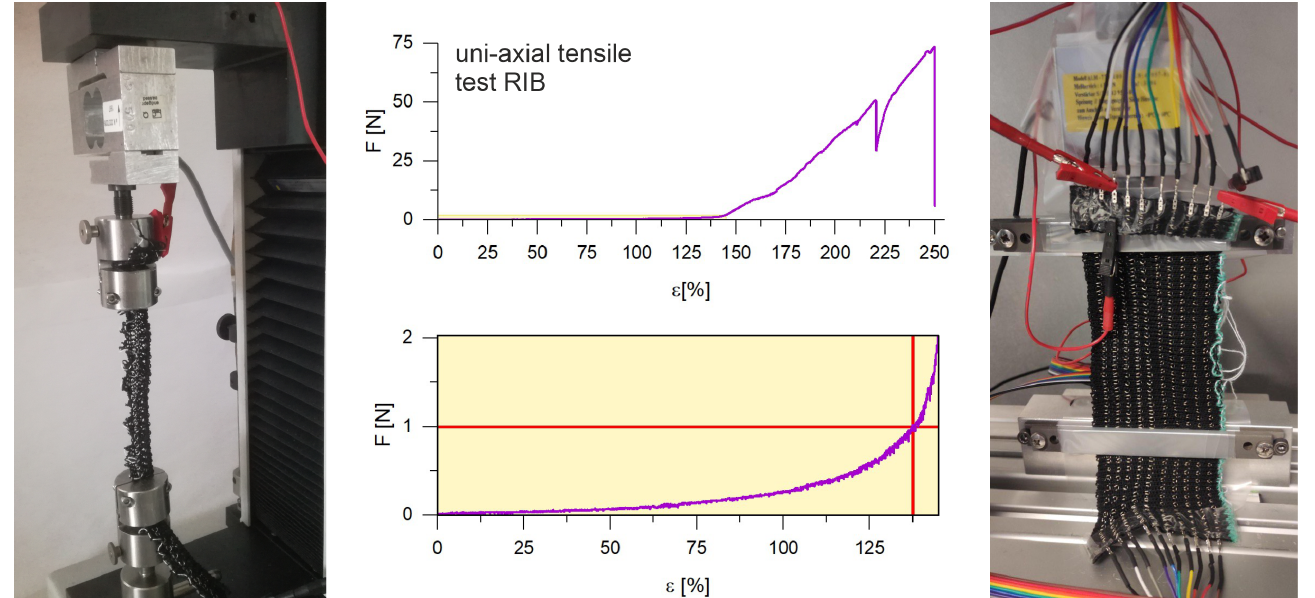
Figure 4. Quality and reliability testing: uni-axial tensile test set-up and test specimen ( left ), de- termination of ε 1N with tensile test results, example for RIB ( center ), cyclic stretch test set-up and test-specimen ( right ).